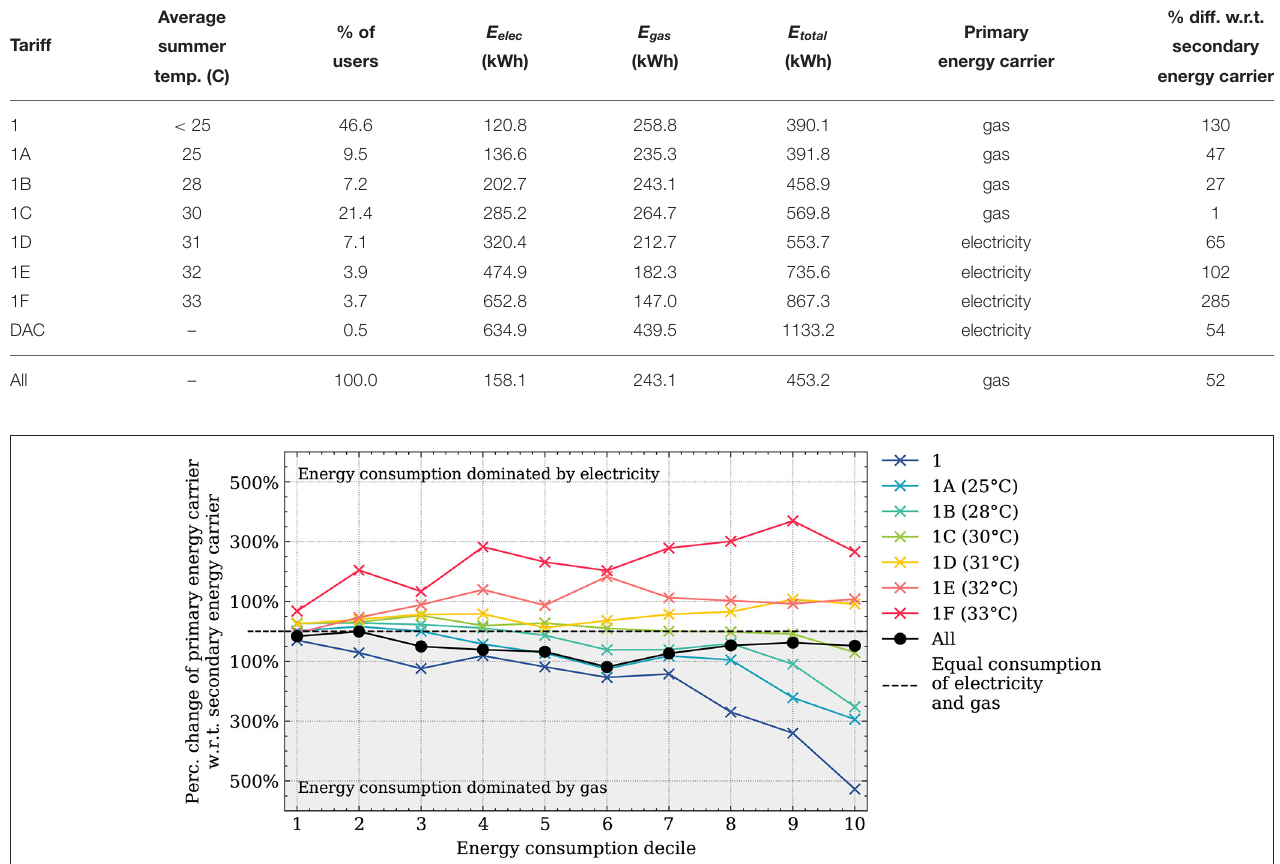
FIGURE 6 | Percentage difference of monthly energy consumption of primary energy carrier with respect to secondary energy carrier by energy consumption decile and electricity tariff